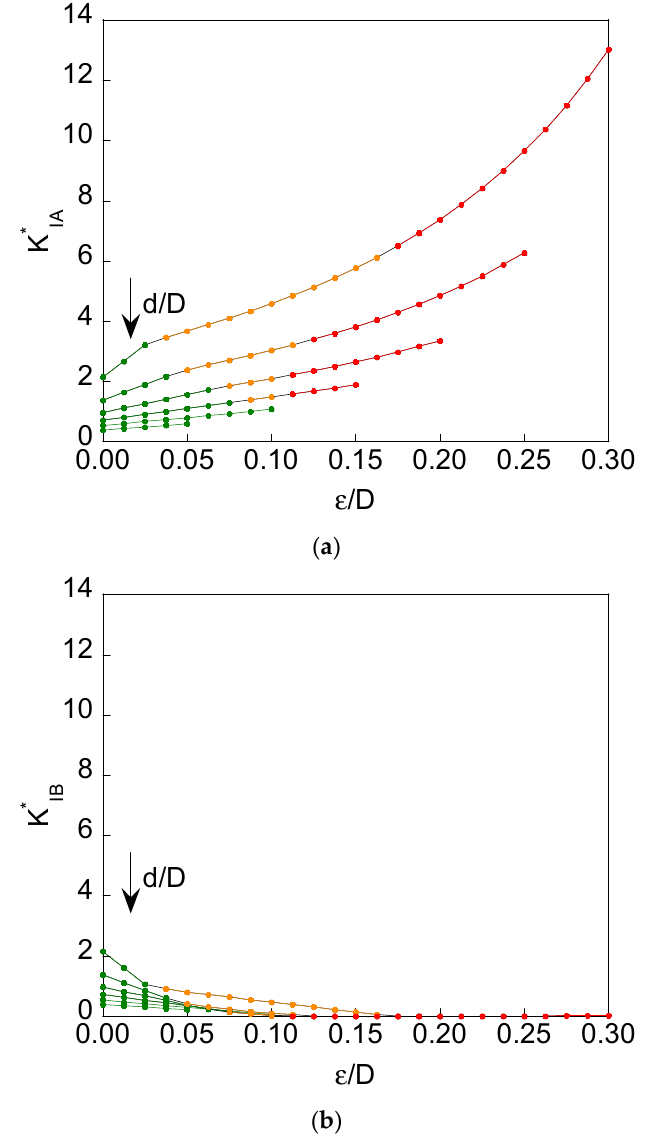
Figure 4. For remote tensile loading and d / D = {0.3, 0.4, 0.5, 0.6, 0.7 and 0.8}: ( a ) maximum dimensionless SIF K * IA vs. relative ligament eccentricity ε / D; ( b ) minimum dimensionless SIF K * IB vs. relative ligament eccentricity ε / D (green: no contact ; orange: partial contact ; red: full contact ).